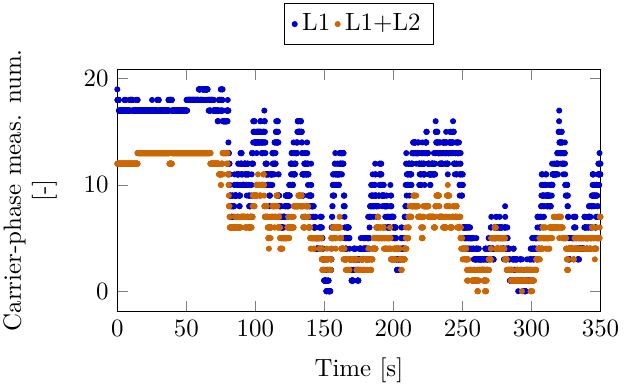
Figure 12. Number of carrier-phase measurements on the two frequencies together and on one frequency only—Case Study